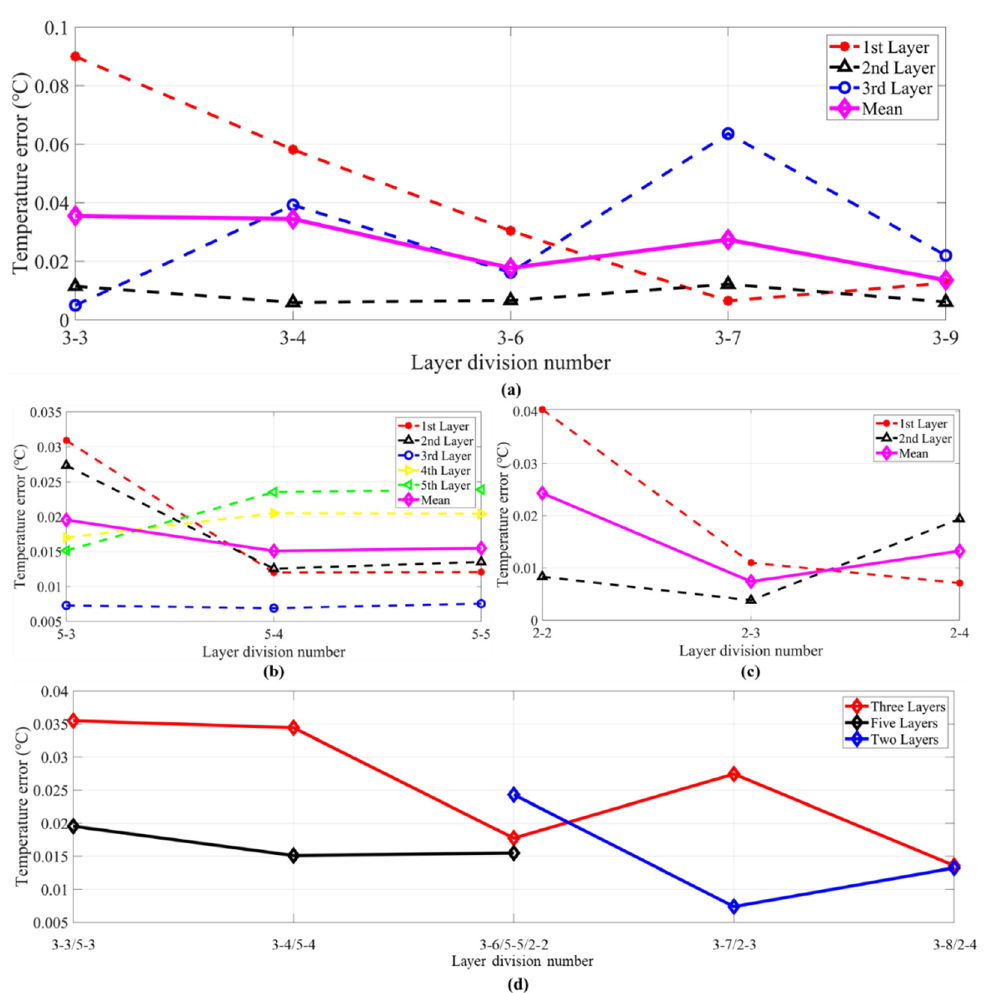
Figure 16. Inversion errors of the second group of S2–S3. ( a ) Temperature error of three layers. ( b ) Temperature error of five layers. ( c ) Temperature error of two layers. ( d ) Mean temperature error of three, five, and two layers. The red, black, blue, green, purple, and magenta curves in ( a – c ) indicate the mean errors of the first, second, third, fourth, fifth layer, and the mean errors of three layers, respectively. The red, black, and blue curves in ( d ) indicate three layers, five layers, and two layers.